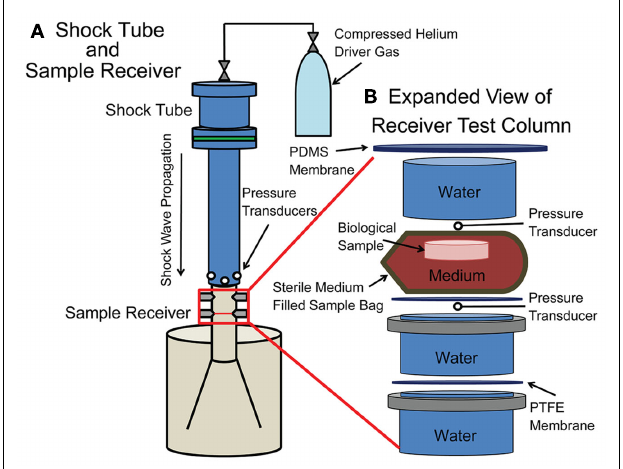
FIGURE 1 | Schematic of the shock tube with receiver. (A) A compressed helium source was connected to an adjustable driver section of the shock tube, which was aligned vertically over the sample receiver. In-air transducers were located at the exit of the shock tube. (B) The sample within a bag rested on top of a PTFE membrane within the fluid-filled sample receiver. Submersible transducers were located directly above the sample bag and below the PTFE